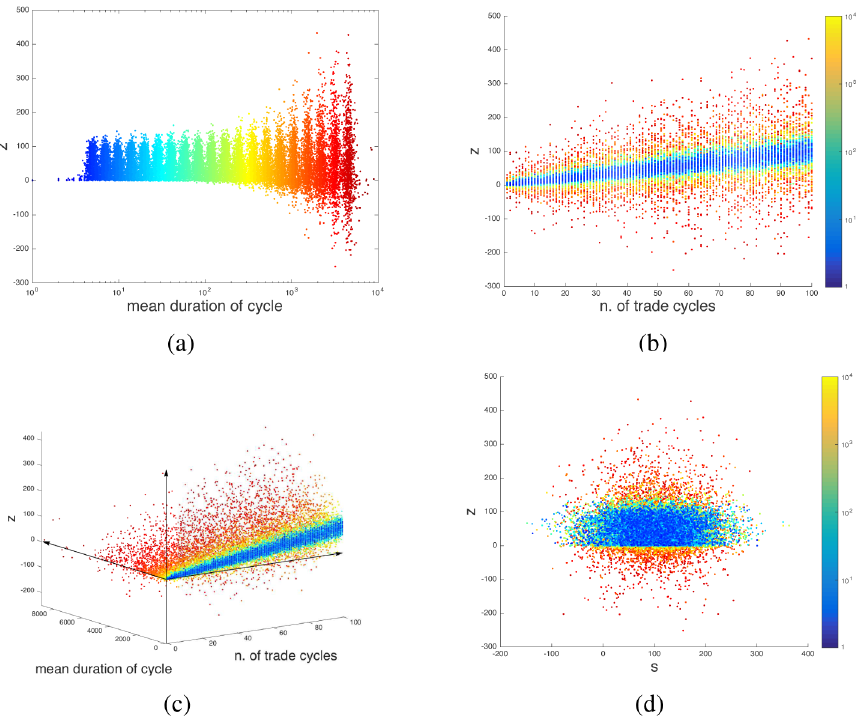
Fig 7. Endpoint of a series of cyclic trading operations, in presence of stock quote spread and quote drift. Each dot is the result of 1000 simulations, under the assumption that z ( t end ) − z (0) (cid:5) 0 when the stock drift is absent (formula (12)). The number of cyclic operations is considered itself a random variable (denoted “ n. of trade cycles ” ), and so is the duration of the holding intervals [ t b , t s ] (denoted “ mean duration of cycle ” ). For short cycles (with respect to the standard deviation σ of the stock drift term), the trader always obtains a profit (panel (a)). The profit is proportional to the number of trade cycles performed by the trader (panel (b)). The correlation tends to get lost when the mean duration of the trade cycles becomes large (red dots in panels (b) and (c)). For short cycles, the profit happens independently of the stock trend (blue dots in panel (d)). Also when the trade cycles become long and profit may be lost, there is no significant correlation between z and s (panel